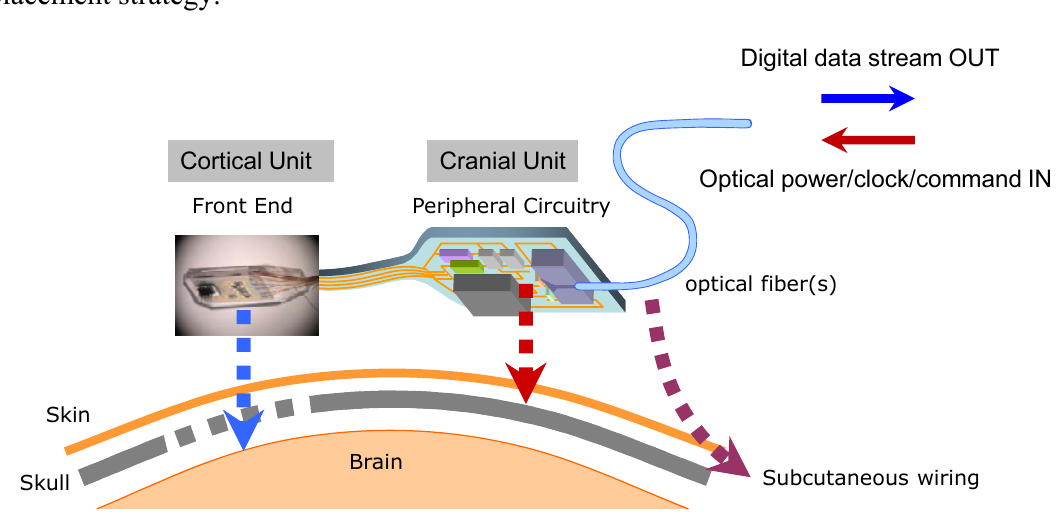
Figure 1. Schematic of the implantable microsystem architecture and anatomical placement strategy.